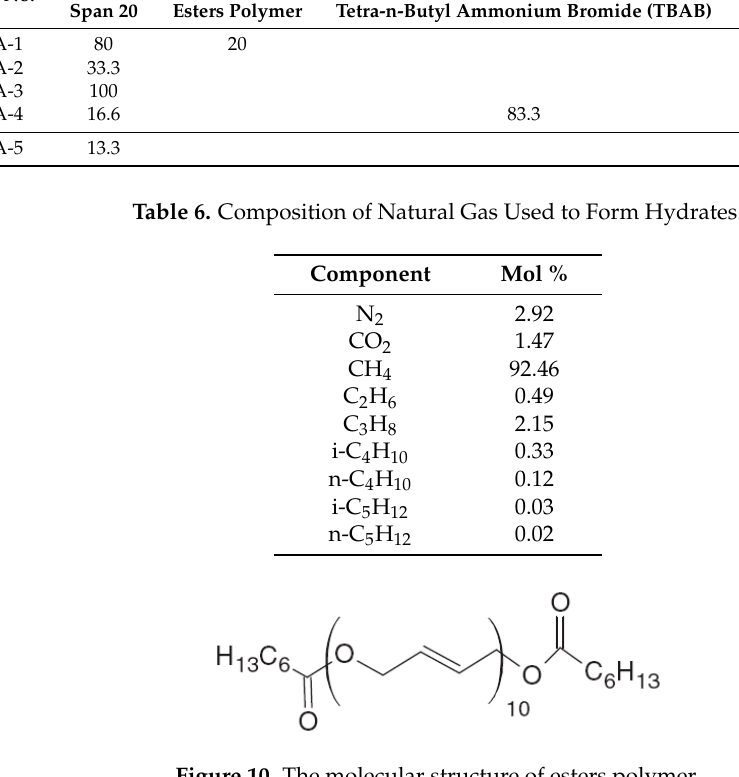
Figure 10. The molecular structure of esters polymer. Table 4. Composition of the Diesel Oil Used in This Work.